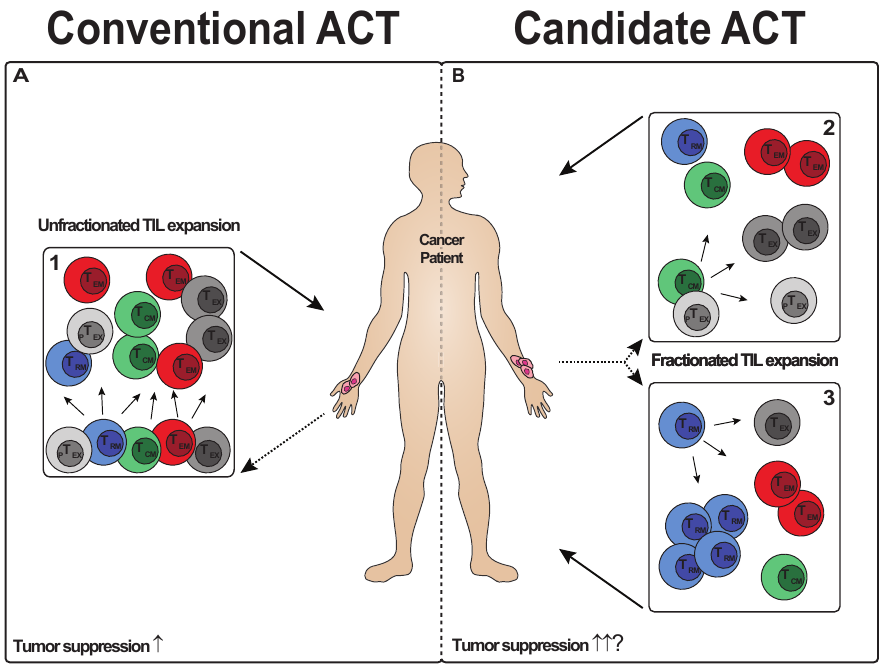
Figure 2. Strategies of conventional and candidate adoptive T cell therapy